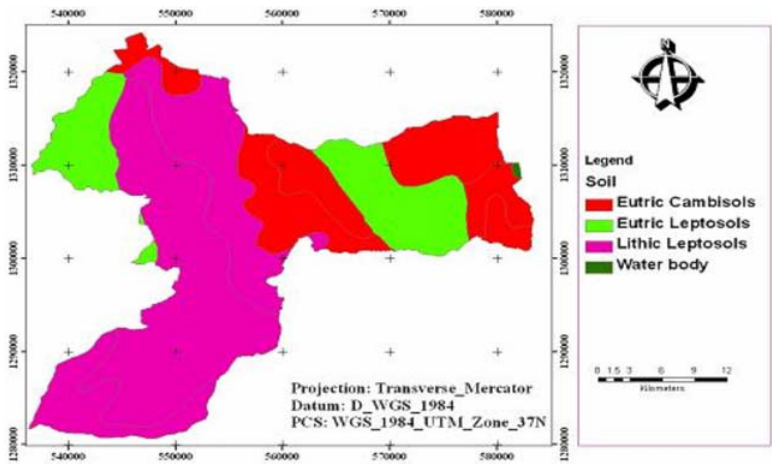
Figure 4. Soil map of the study district.